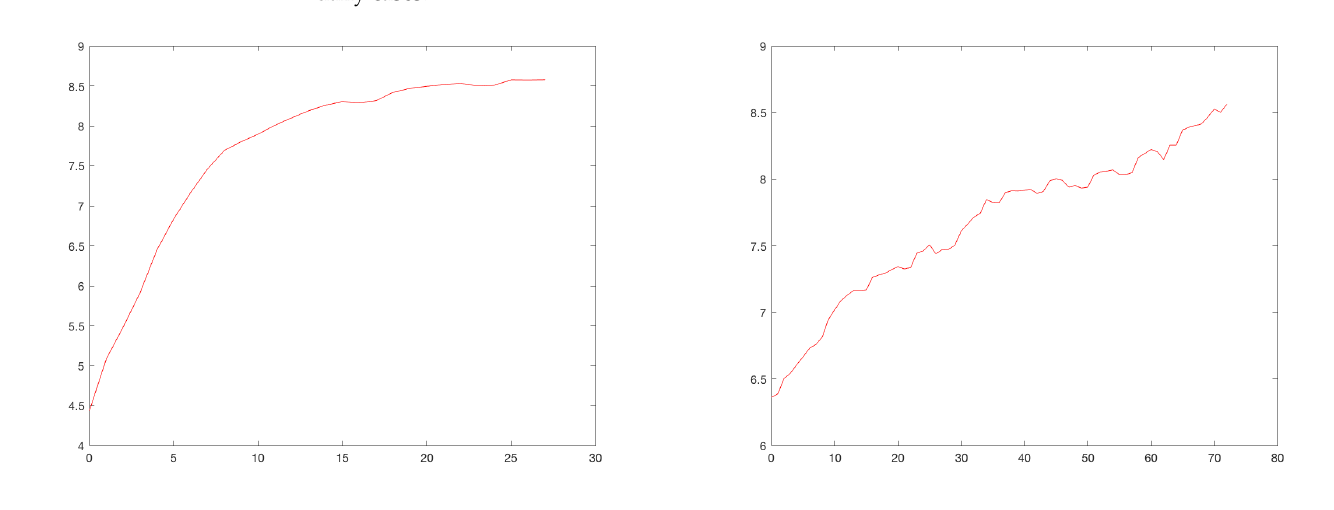
Figure A21. New York’s rises. Horizontal axis, days; vertical axis: logarithm of daily